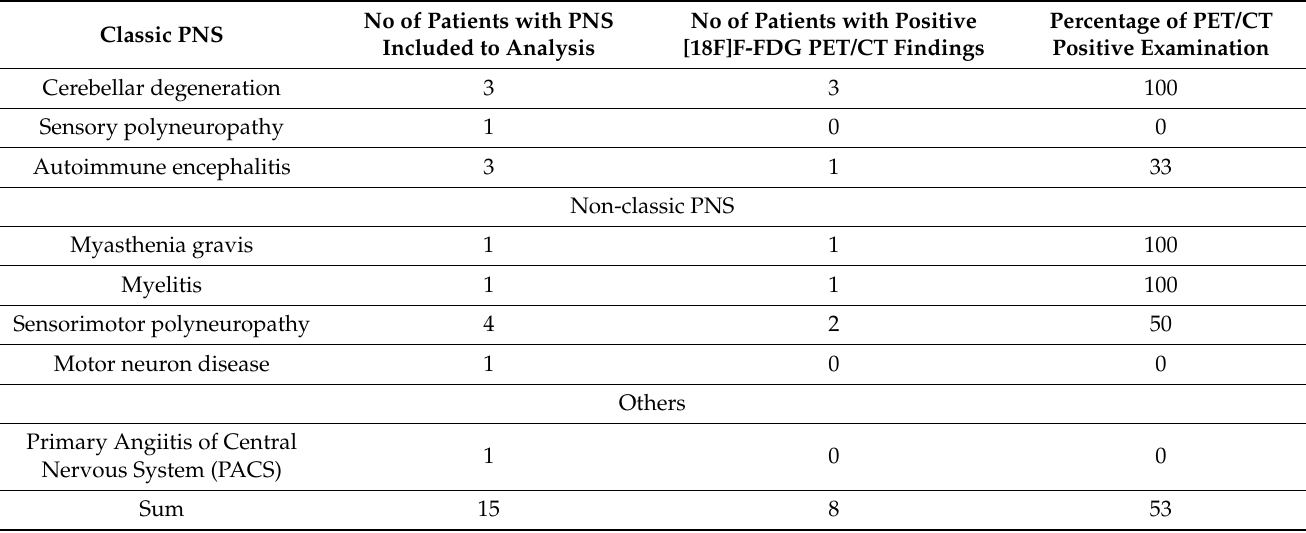
Table 4. The distribution of PNS types diagnosed among the analyzed group and the results of [18F]FDG